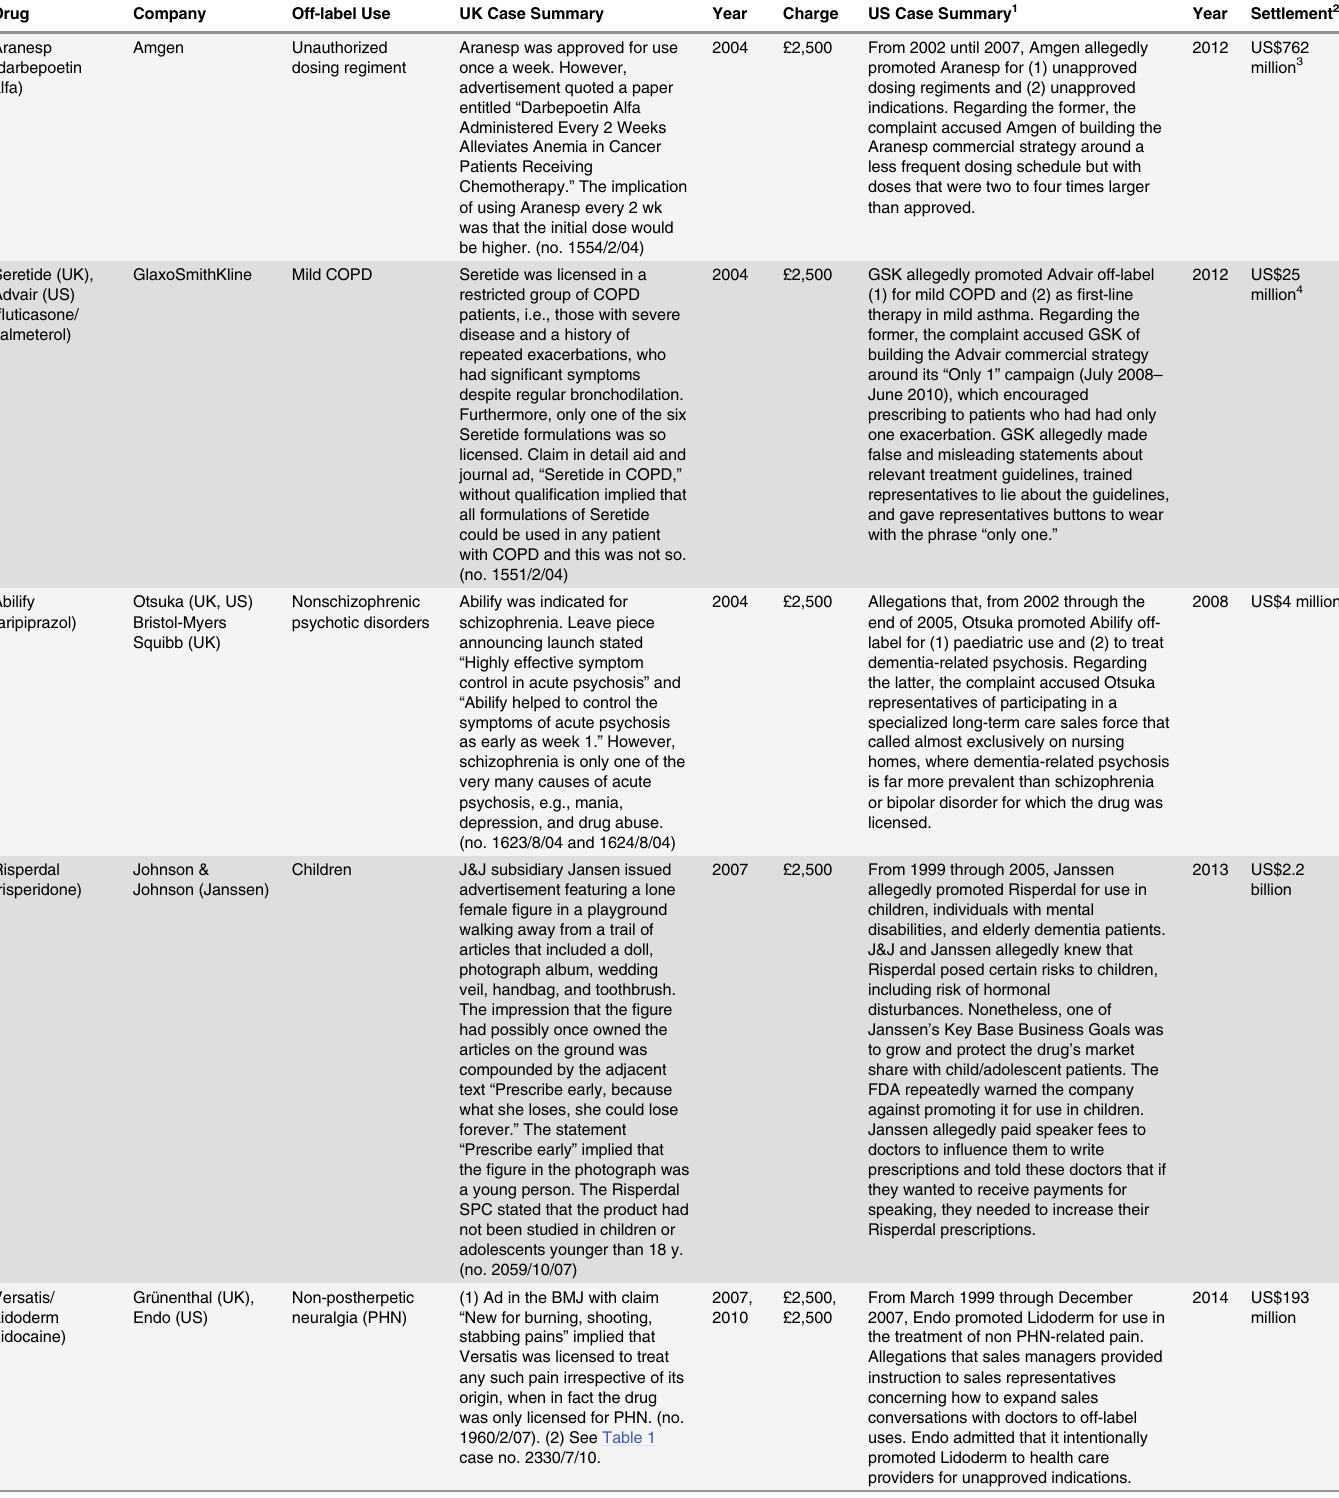
Table 4. UK and US off-label promotion cases involving the same drug for the same off-label use.